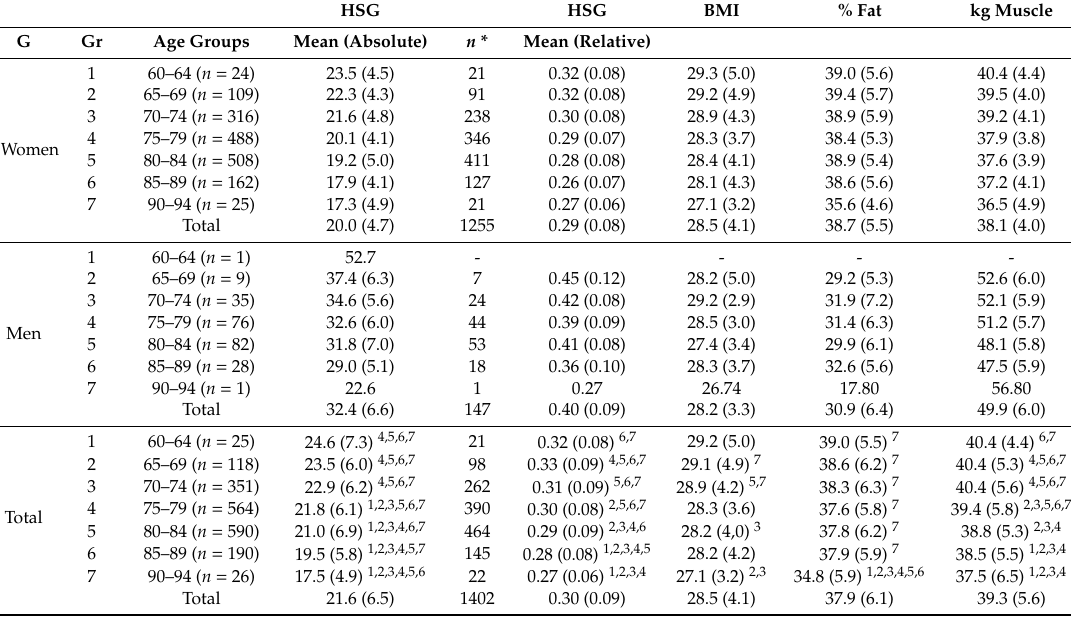
Table 3. Age groups and gender di ff erences.